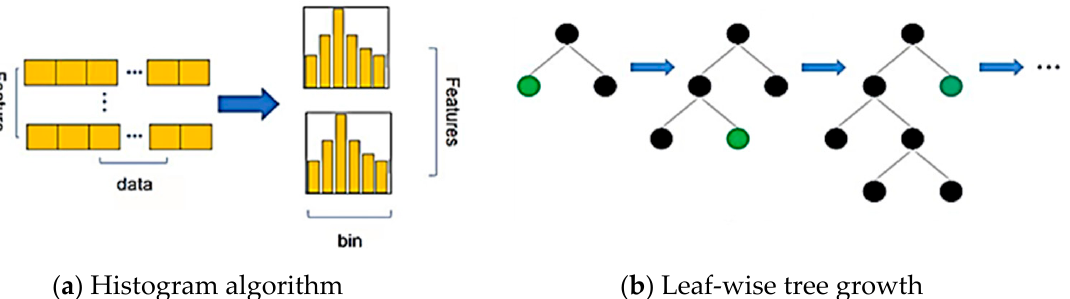
Figure 2. Schematic illustrations of ( a ) histogram-based algorithms and ( b ) the LightGBM algorithm model training strategy.